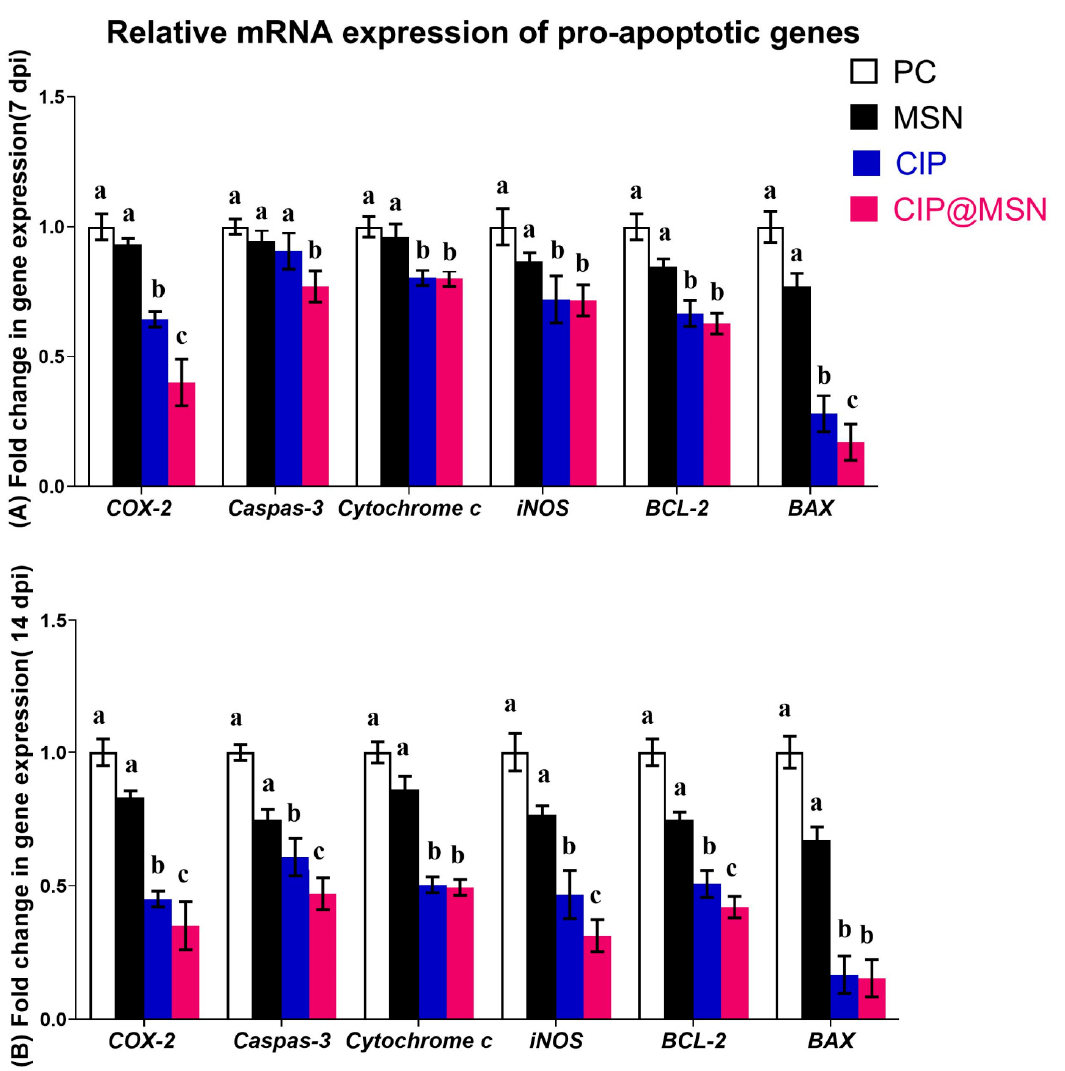
Figure 5. Relative mRNA expression levels of pro-apoptotic genes; Cyclooxygenase-2( COX-2 ), caspase-3, Cytochrome P450, inducible nitric oxide synthase ( iNOS ), B-cell lymphoma-2 ( Bcl-2 ), and Bcl-2-associated X ( BAX )in the splenic tissue of rats treated with CIP–MSN compared with CIP alone at ( A ) 7 and ( B ) 14 days postinfection with S. typhimurium (7 and 14 dpi).The expression levels were calculated using the -2 ∆∆ CT method and expressed as fold change, and glyceraldehyde-3-phosphate dehydrogenase (GAPDH) was used as the endogenous control. PC (positive control): rats received a control diet without any addition and were orally challenged with S. typhimurium ; MSN(mesoporous silica particles): rats received a control diet, were orally challenged with S. typhimurium , and received 10 mg/kg MSN orally twice a day for 3 days; CIP(ciprofloxacin): rats received a control diet, were orally challenged with S. typhimurium , and received 10 mg/kg CIP orally twice a day for 3 days; and CIP–MSN (MSN particles loaded with ciprofloxacin): rats received a control diet, were orally challenged with S. typhimurium , and received 5 mg/kg CIP orally twice a day for 3 days. Each column shows the mean ± SD of three independent experiments. a–c Means within the same column carrying different superscripts are significantly different at p <